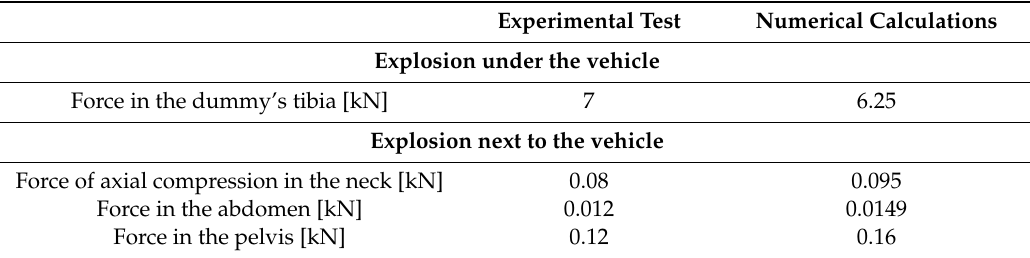
Table 4. Comparison of the results obtained on the basis of the experimental tests and numerical calculations.